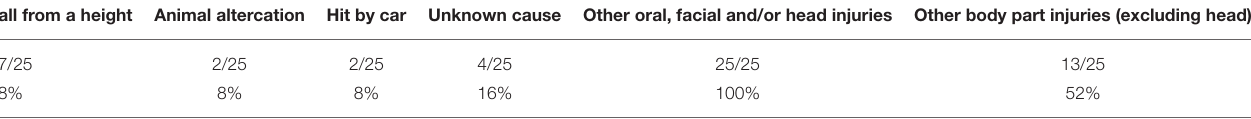
PDE, Palate defect.